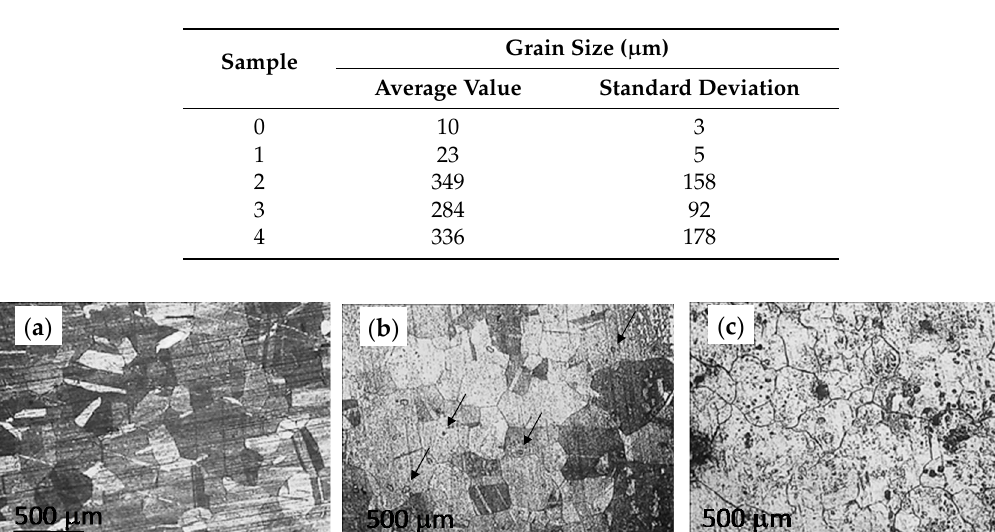
Table 2. Average grain size determined from the optical micrographs.